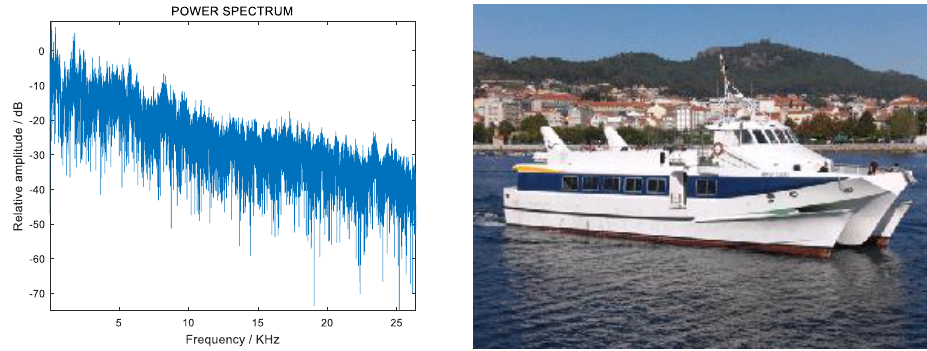
Figure 1. Radiated noise power spectrum ( left ) and picture ( right ) of a passenger ship.